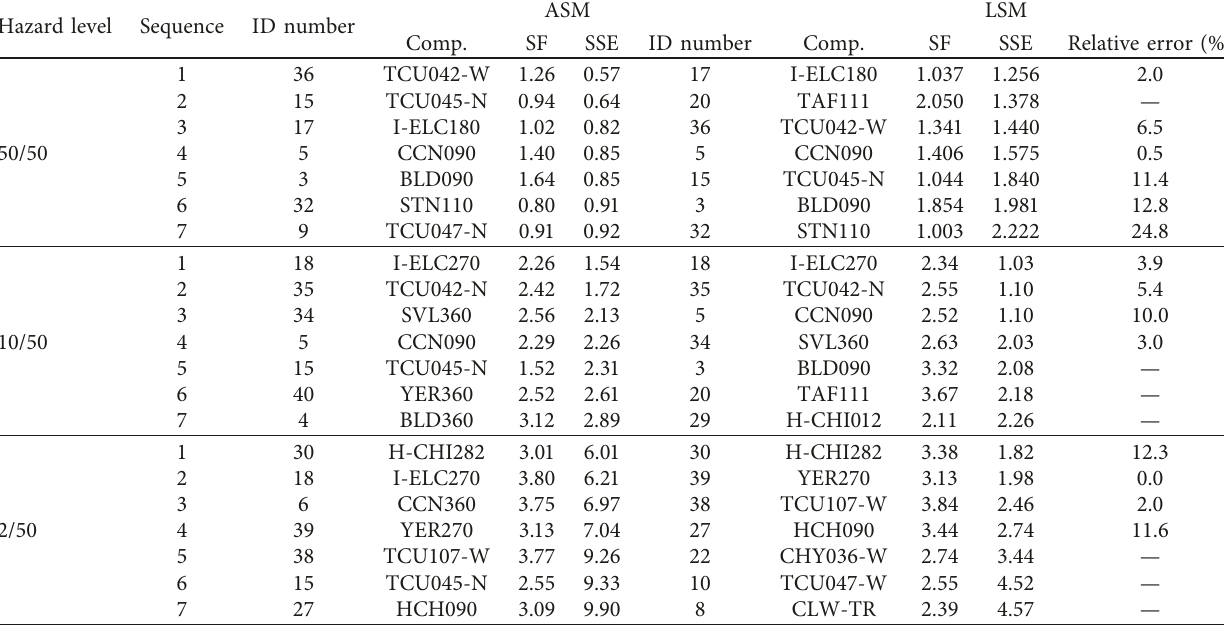
Figure 3: . Comparison of the (a) arithmetic and (b) logarithmic values of the target spectrum and the scaled record’s spectrum (e.g., I-ELC180, 9-story, 2/50 hazard Table 3: Components selected by ASM and LSM methods at the three hazard levels (3-story).